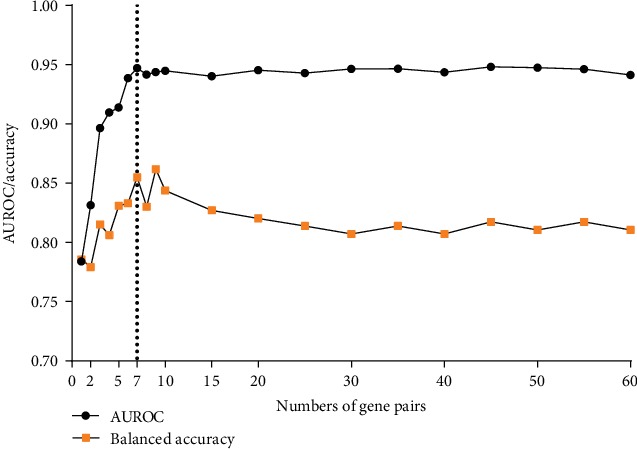
The AUROC and balanced accuracy of number features in a k-TSP classifier selected from the 60 top-ranked gene pairs in the discovery set. We selected gene pairs from 1 to 60 to develop the TRGP classifier and found that the TRGP classifier with seven of the top gene pairs (dotted line) optimally achieved the best AUROC and balanced accuracy performance.